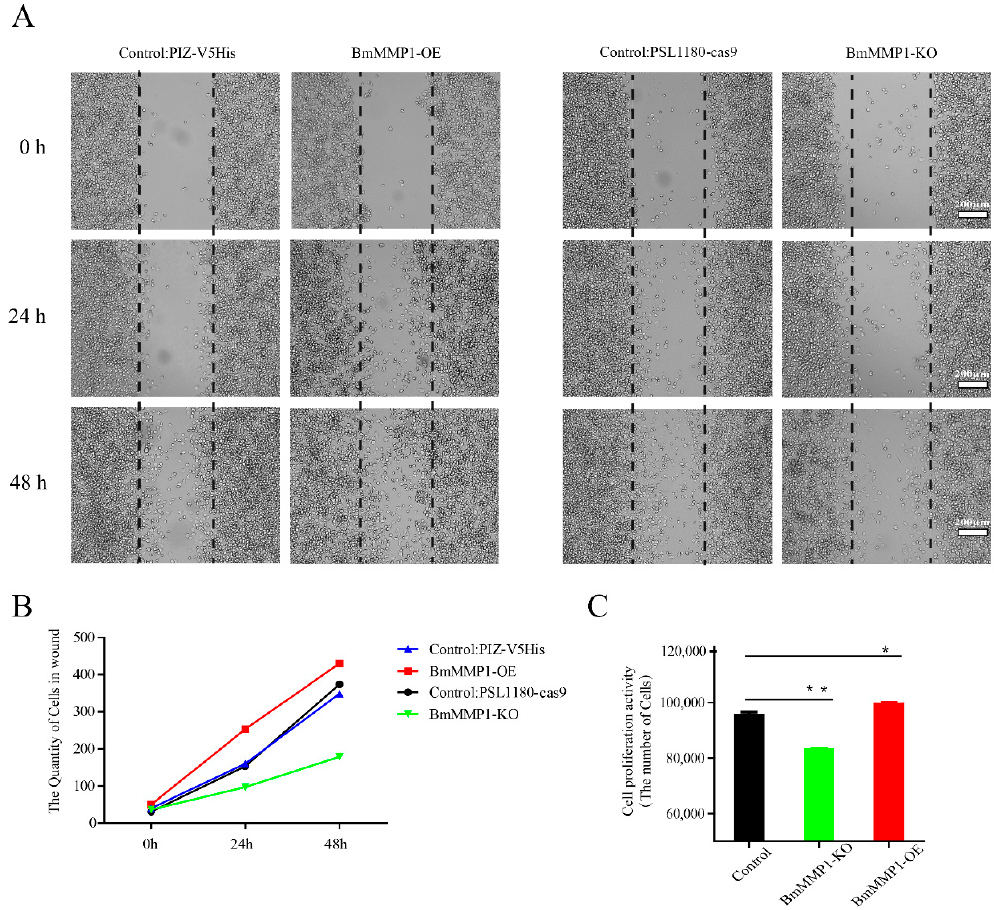
Figure 7. BmMMP1 affects silkworm cells migration and proliferation. ( A ) Wound healing assay in BmNS cells for 0 h to 48 h. The BmMMP1 overexpression group and knockout group have different control because of the expression vectors. ( B ) Statistics of the results of the cell wound healing assay. ( C ) MTS assay was used to determine the cell proliferation ability. Black column represented the control experimental group, green represented knockout of BmMMP1, red repre- sented overexpression of BmMMP1. (*, 0.01 ≤ p < 0.05; * *, p < 0.01).